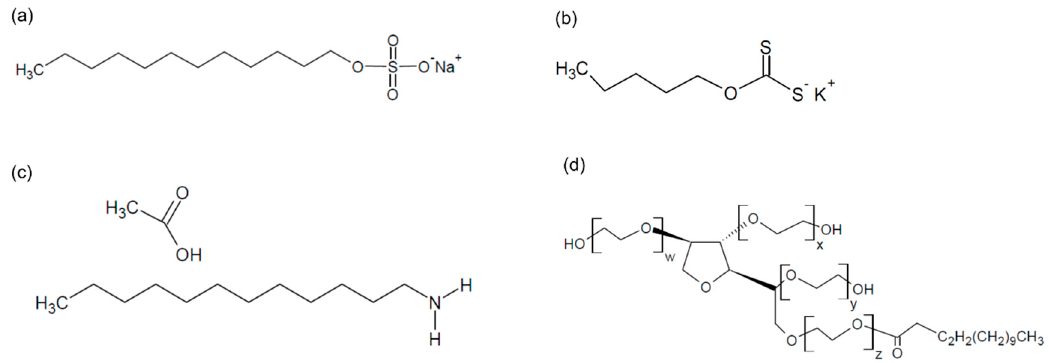
Figure 1. Chemical structures of emulsifiers: ( a ) SDS, ( b ) KAX, ( c ) DAA, and ( d ) Tween 20.